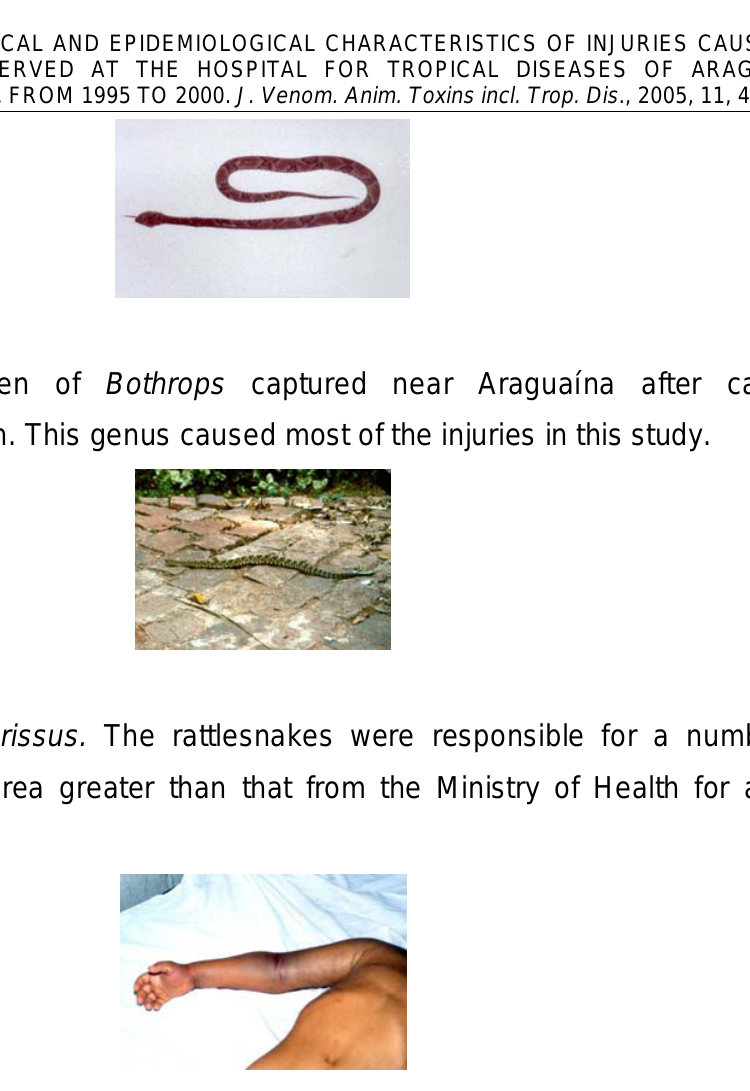
Figure 3: The arm of a victim bitten by a Bothrops snake. Note the edema, erythema and ecchymosis.